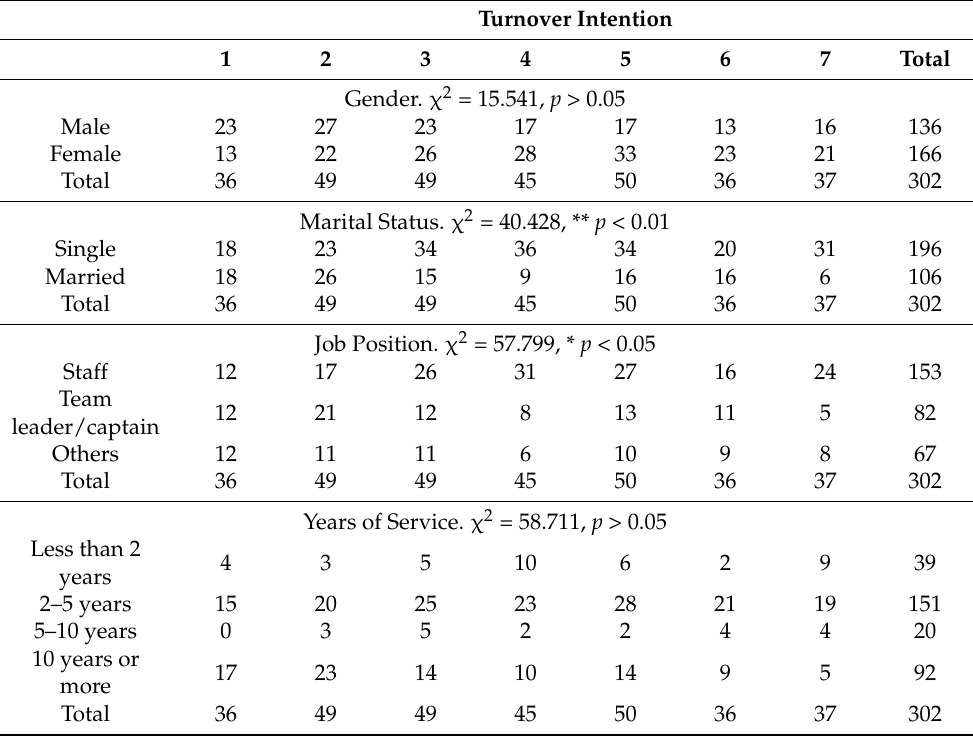
Table 5. The crosstabulation of demographic